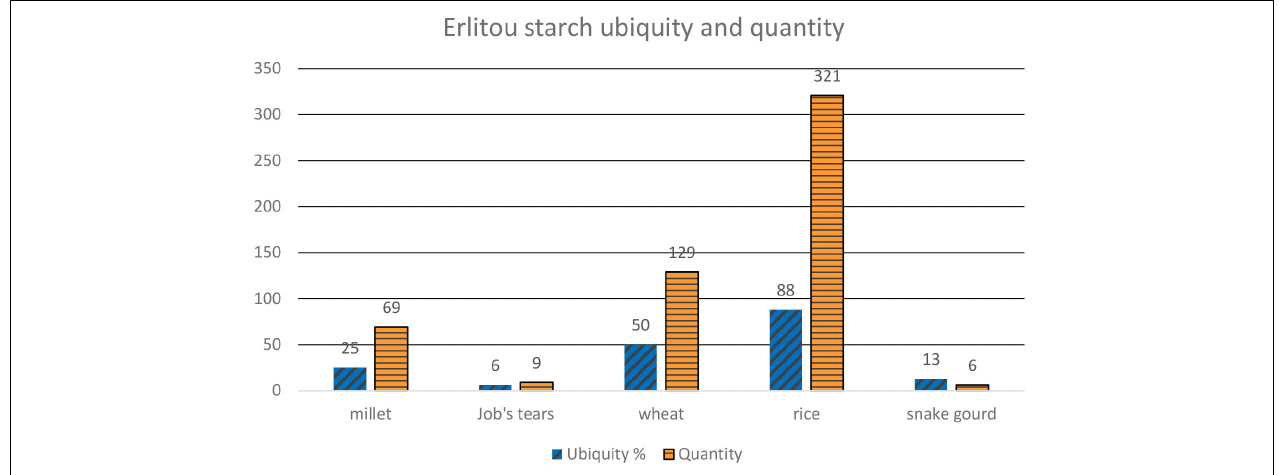
FIGURE 7 | Comparison of starch ubiquity (%) and quantity among alcohol-brewing ingredients at